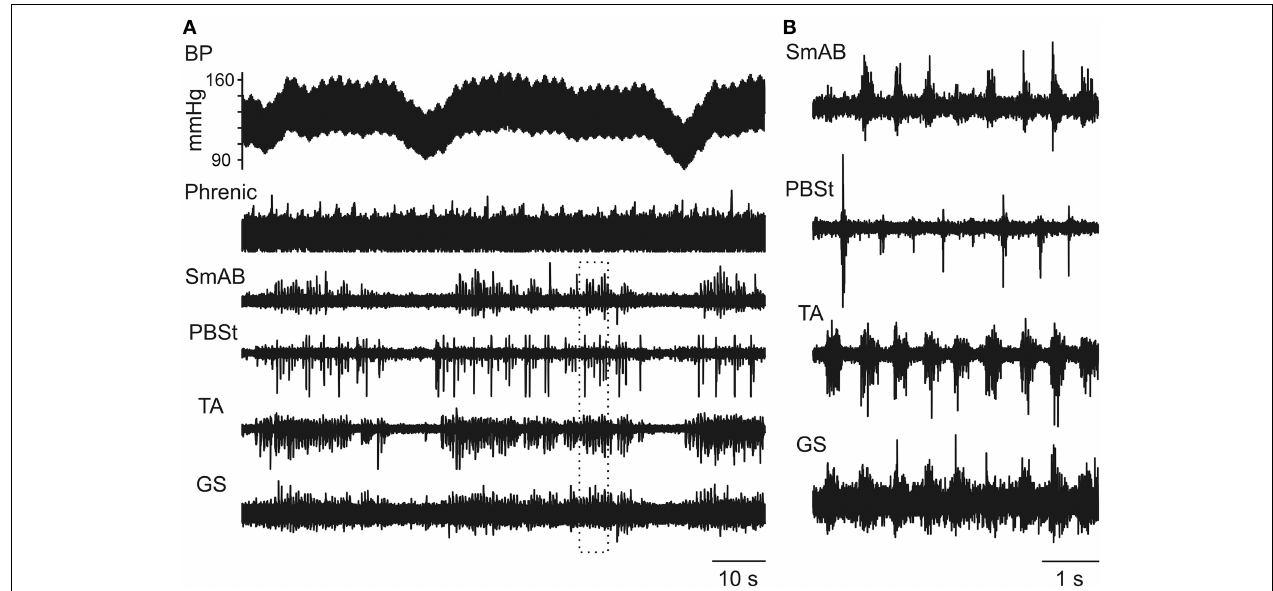
FIGURE 3 | Spinal locomotor-like activity may be initiated in relation to Mayer waves. (A) Three Mayer wave cycles are illustrated, where these consisted of relatively short-lasting hypotensive phases from a more steady value. Note that intermittent nerve discharges commence at the BP increase and cease at the BP drop. The alternation between discharges in the different nerves during